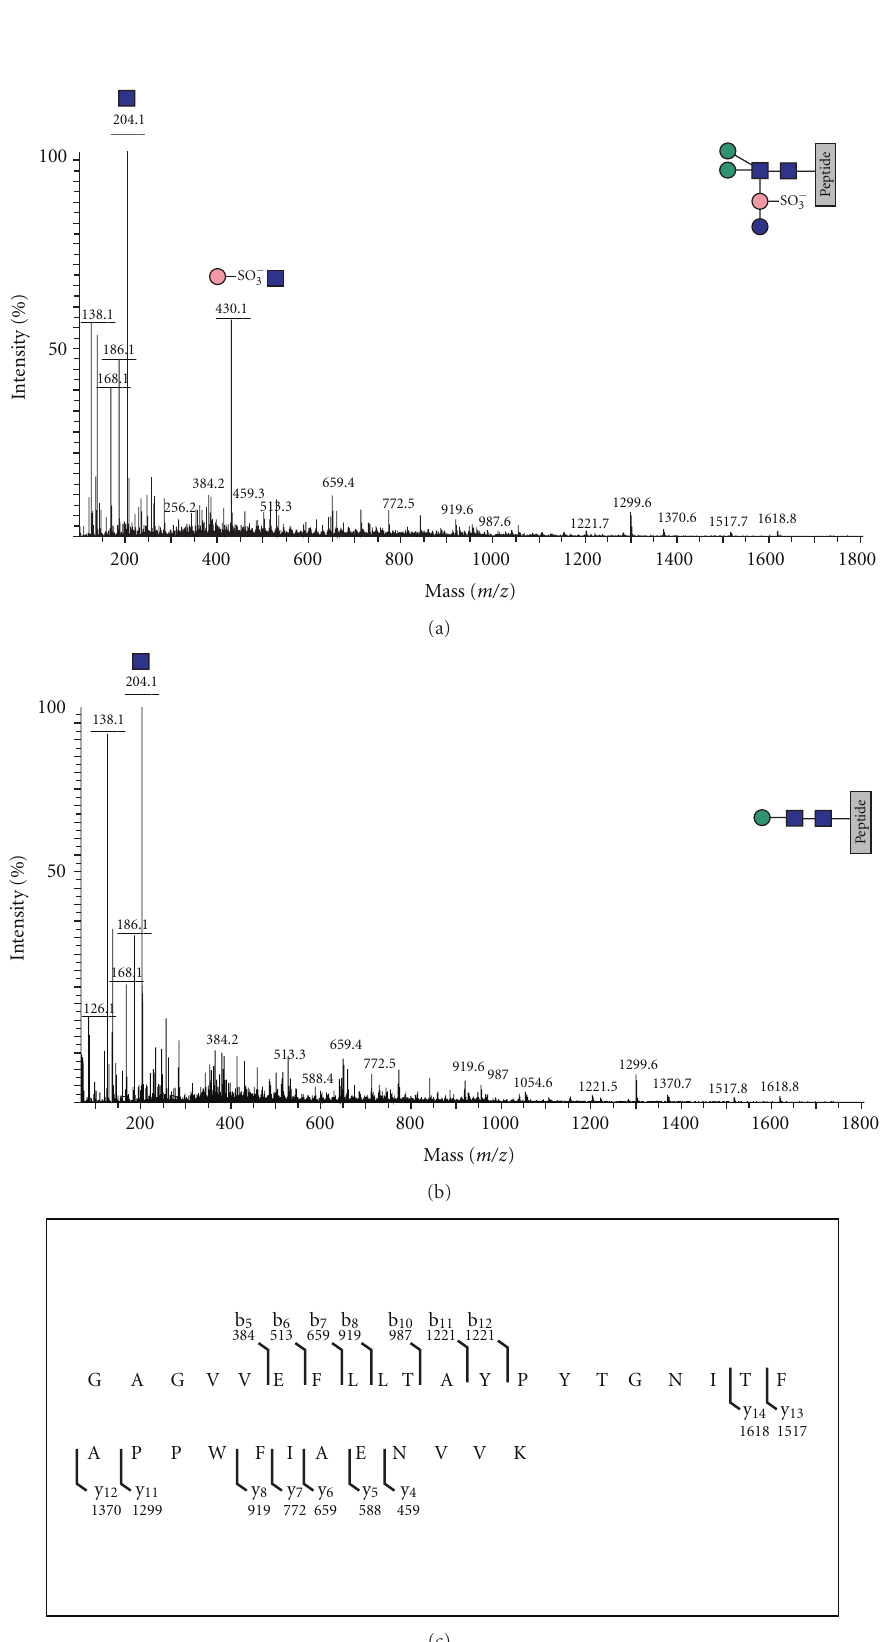
Figure 5: MS/MS of m/z 1151.09 (a) and m/z 1014.07 (b) (see mass spectrum in Figure 4). Note the diagnostic fragment ions for HexNAc in both spectra and for HexNAc-QuiS in (a). The peptide sequence ions are identical in (a) and (b), and their assignments are shown in